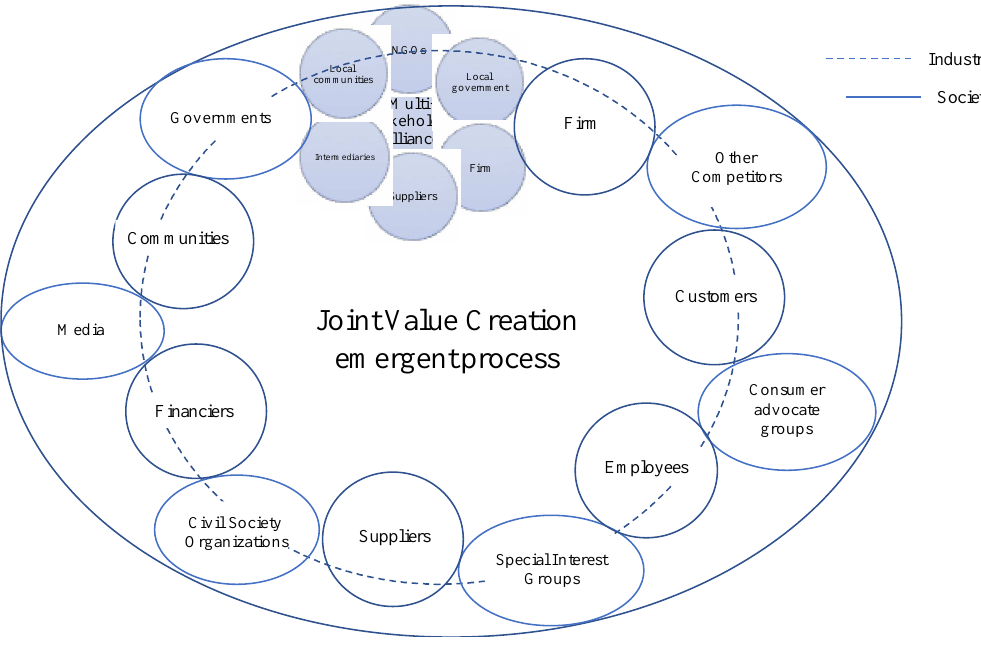
Figure 1 : Multi-Stakeholder Value